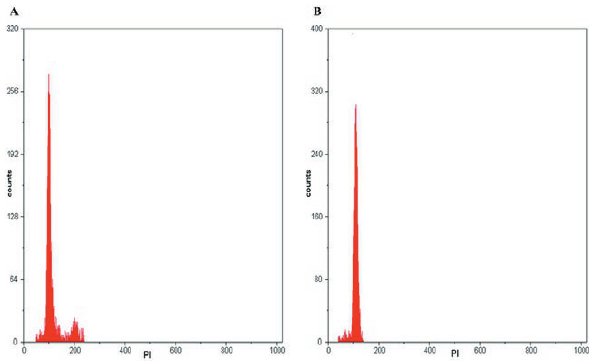
Table 4. Frequency (%) of Allium cepa nuclei in cell cycle phases after treatment with Aristolochia labiata and Aristolochia triangula-